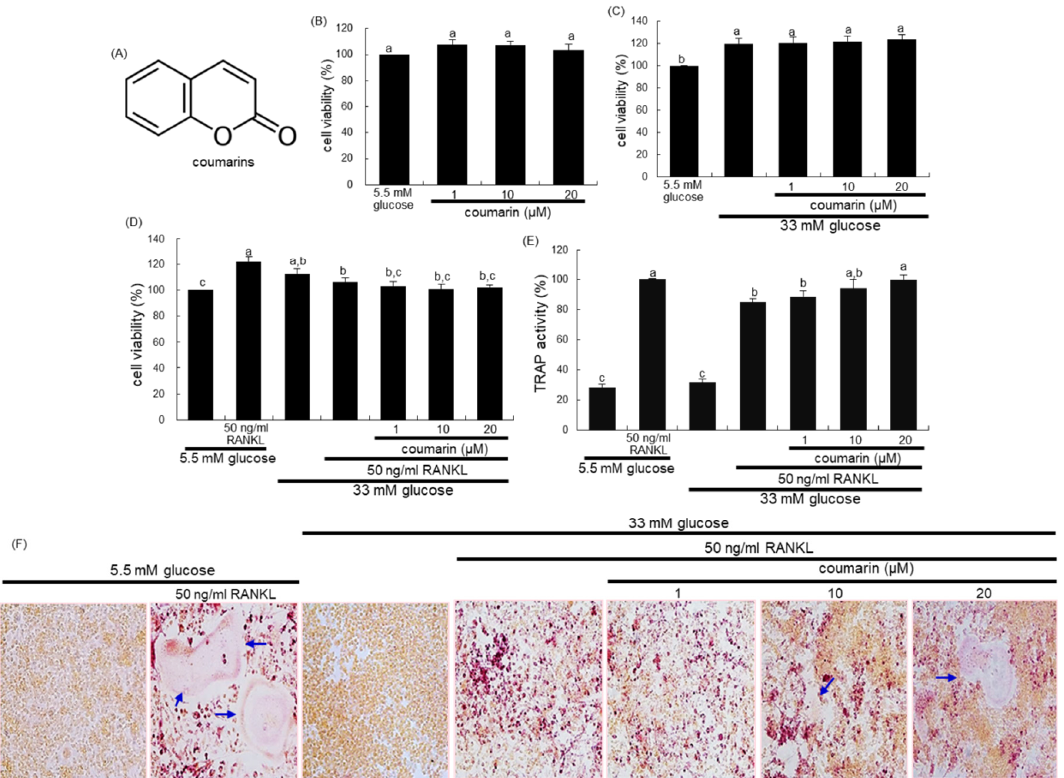
Figure 1. Chemical structure of coumarin ( A ), cell cytotoxicity of coumarin in osteoclastic Raw 264.7 cells ( B – D ), tartrate ‐ resistant acid phosphatase (TRAP) activity ( E ), and TRAP staining ( F ). Raw 264.7 cells were cultured in an α‐ MEM media containing 5.5 mM glucose or 33 mM glucose for two days in the absence and presence of 1 – 20 μ M coumarin or 50 ng/mL receptor activator of the NF ‐ kappa B ligand (RANKL). Cell viability was measured by the MTT assay and expressed as percent cell survival relative to 5.5 mM glucose controls (cell viability = 100%, mean ± SEM, n = 6). After Raw 264.7 cells were cultured for five days, TRAP-positive activity was measured at λ = 405 nm using a leukocyte acid phosphatase kit (E, mean ± SEM, n = 3), and TRAP-positive multinucleated osteoclasts were stained and visualized under light microscopy ( F ). Blue arrows indicate the differentiated osteoclasts. Magnification: 20 ‐ fold. Values in the bar graphs not sharing a common letter indicate significant difference at p < 0.05.